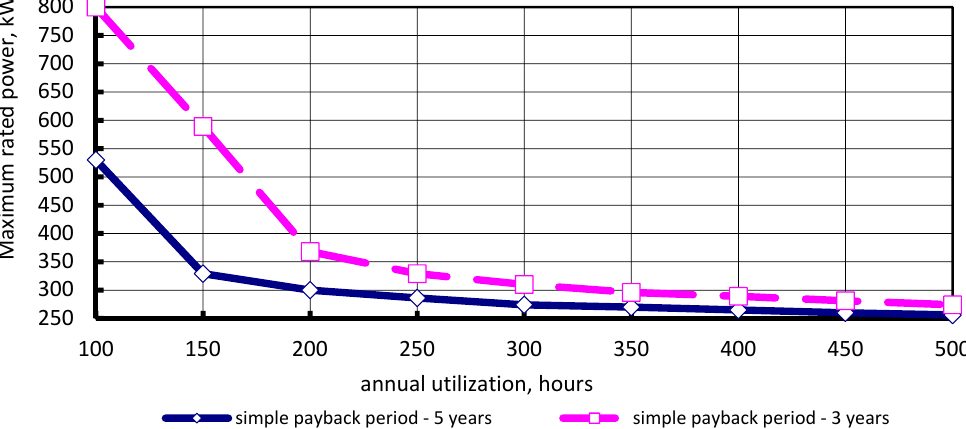
Figure 6. Maximum rated power vs annual utilization (diesel fuel price—USD/L). Source: developed by authors.